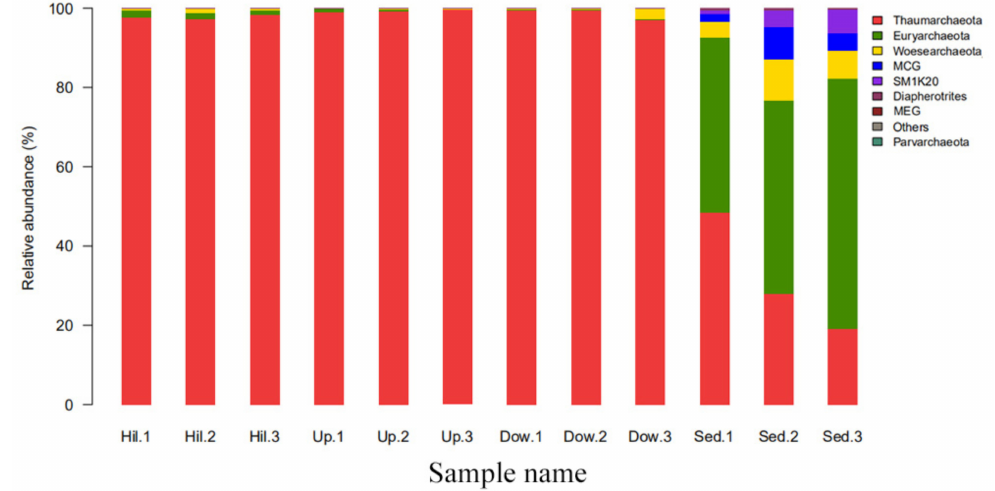
Figure 4. The top 10 abundance of the di ff erent phyla in the 12 soil samples of the present study.